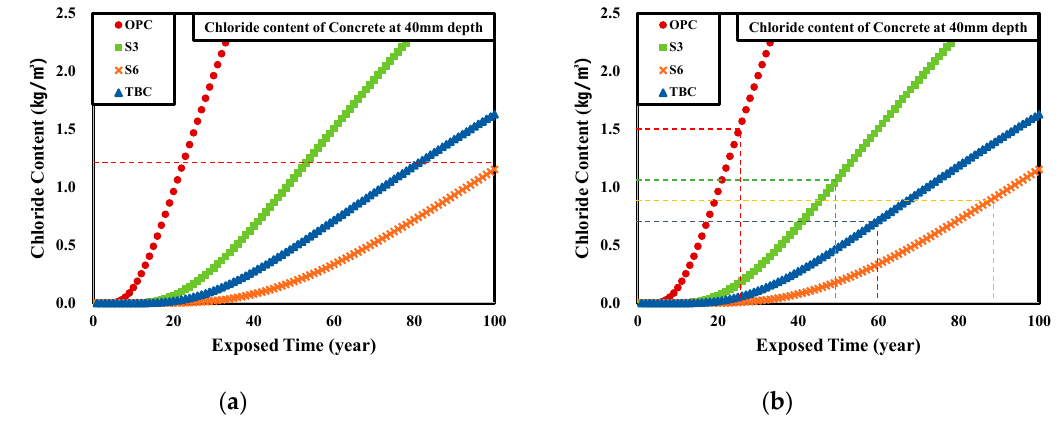
Figure 12. Variation of service life on the RC structure by concrete binder type: ( a ) Before (Korean standard) critical chloride content and ( b ) improved critical chloride content.